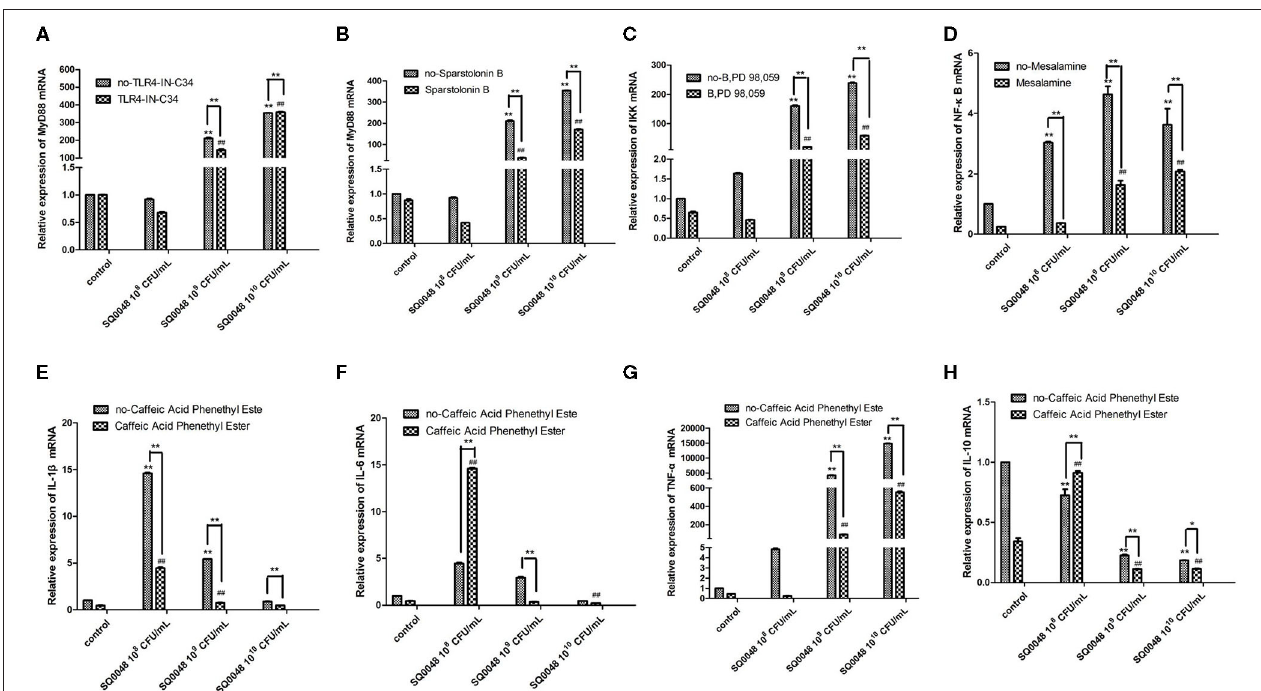
FIGURE 2 | mRNA expression levels of MyD88 (A,B) , IKK (C) , NF- κ B (D) , IL-1 β (E) , IL-6 (F) , TNF- α (G) , and IL-10 (H) after treatment with inhibitors in BVECs. Note: (A) TLR4-IN-C34 (5 µ m) for 30min, (B) Sparstolonin B (10 µ m) for 120min; (C) B, PD98,059 (20 µ m) for 90min; (D) Mesalamine (1mm) for 60min; (E) Caffeic Acid Phenethyl Ester (20 µ m) for 60min; (F) Caffeic Acid Phenethyl Ester (20 µ m) for 60min; (G) Caffeic Acid Phenethyl Ester (20 µ m) for 60min; (H) Caffeic Acid Phenethyl Ester (20 µ m) for 60min. All data are shown as means ± SD ( n = 3). * or # indicating P < 0.05 and ** or ## indicating P < 0.01. *refers to the comparison between cells in the cell control group not exposed to any treatment and other groups exposed to different concentrations of SQ0048 without inhibitor treatment; it also refers to the comparison between the group without inhibitors and the group with inhibitors at the same concentration of SQ0048; # refers to the comparison between the inhibitor control group with inhibitors but not SQ0048 and other groups with